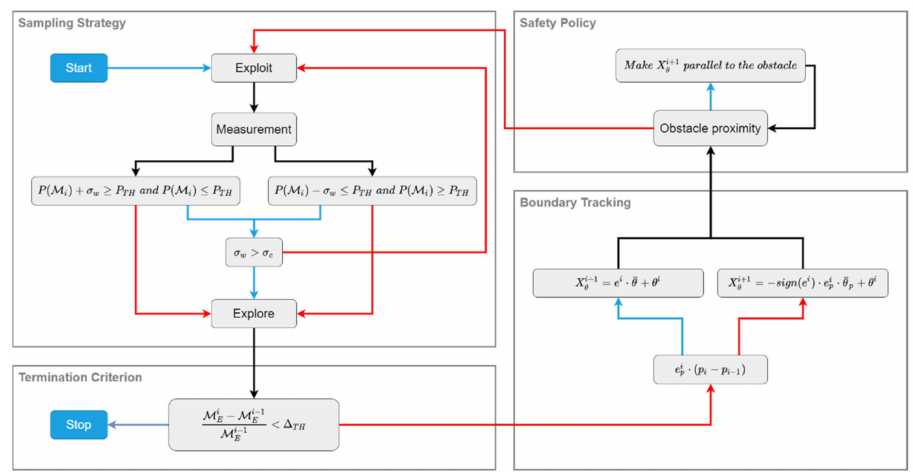
Figure 3. The BREEZE approach. The red and blue arrows in the diagram represent false (red) and true (blue)